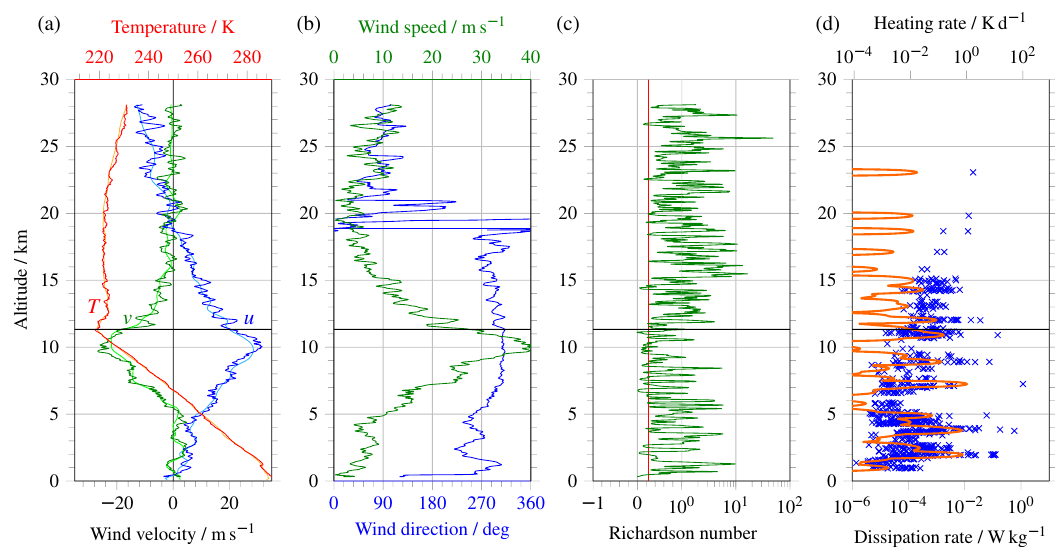
Figure 5. Same as Fig. 1, but for the flight from Kühlungsborn at 11/12 July 2015. The dissipation profile excludes the lowermost 550m due to disturbances from the launch procedure (dereeling of the payload